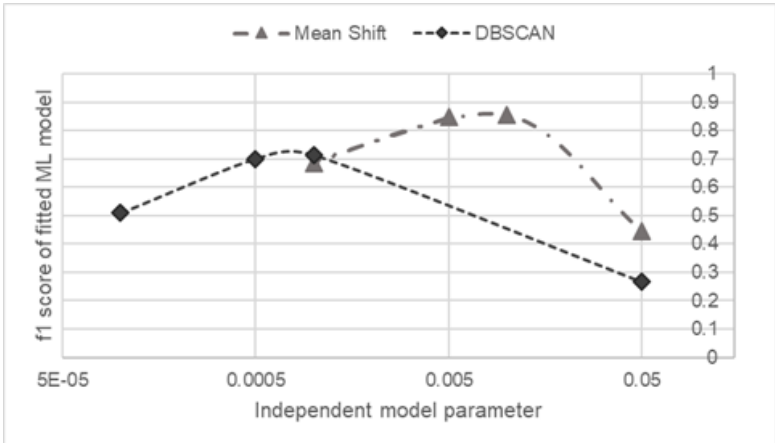
Figure 3. Fitting the hyper-parameter values for Mean Shift and